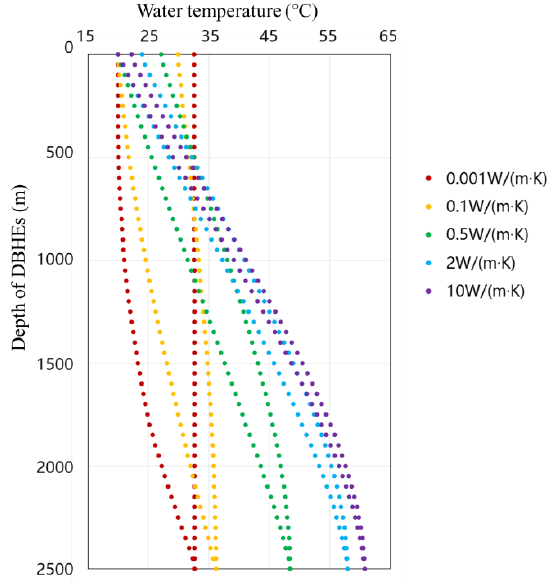
Figure 18. Effect of thermal conductivity of inner pipe on the water temperature